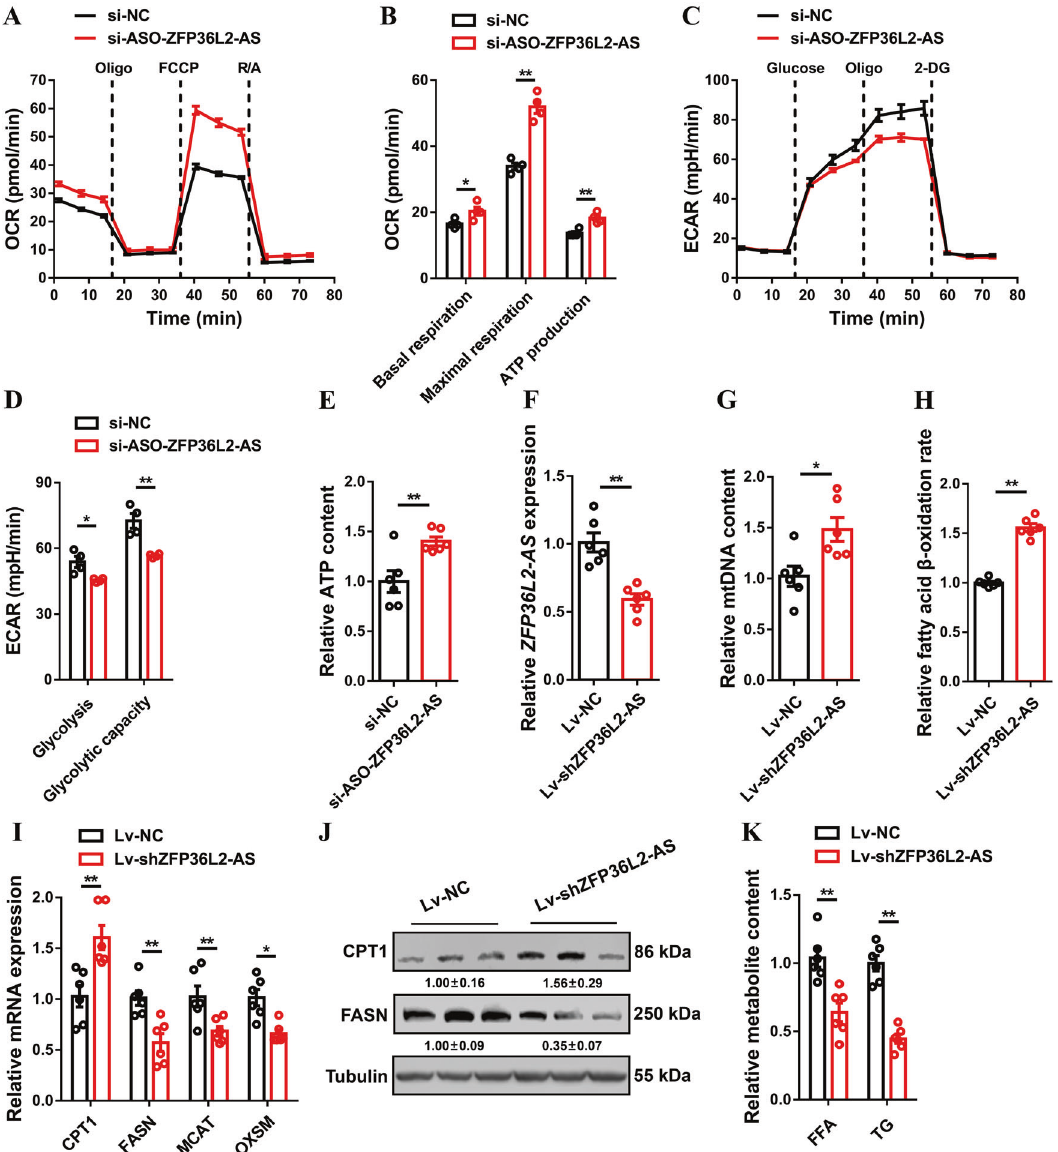
Fig. 3 lncRNA ZFP36L2-AS represses cellular respiration and fatty acid oxidation in skeletal muscle. A , B Oxygen consumption rate (OCR) ( A ), and basal respiration, maximal respiration, and ATP production ( B ) of myoblasts after interference of ZFP36L2-AS . ( C , D ) Extracellular acidi fi cation rate (ECAR) ( C ), and glycolysis and glycolytic capacity ( D ) of myoblasts with ZFP36L2-AS interference. E Relative cellular adenosine triphosphate (ATP) content with ZFP36L2-AS interference in CPMs. F Relative ZFP36L2-AS expression in gastrocnemius after infected with lentivirus-mediated ZFP36L2-AS knockdown (Lv-shZFP36L2-AS) or negative control (Lv-NC). G Relative mitochondrial DNA (mtDNA) content in ZFP36L2-AS knockdown gastrocnemius. ( H ) Relative fatty acid β -oxidation rate in gastrocnemius with ZFP36L2-AS knockdown. I , J Relative mRNA ( I ) and protein ( J ) expression levels of fatty acid oxidation or synthesis related-genes after infected with the indicated lentivirus. The numbers shown below the bands were folds of band intensities relative to control. Band intensities were quanti fi ed by ImageJ and normalized to β -Tubulin. Data are expressed as a fold-change relative to the control. K Relative free fatty acid (FFA) and triglyceride (TG) content in gastrocnemius with ZFP36L2-AS knockdown. Results are presented as mean ± SEM. In panels ( B , D – I , and K ), statistical signi fi cance of differences between means was assessed using independent sample t -test. (* P < 0.05; ** P < ZFP36L2-AS interference, whereas ZFP36L2-AS overexpression and MyHC were signi fi cantly downregulated with ZFP36L2-AS facilitated glycolysis (Fig. 3A – D and Supplementary Fig. 3A – D), interference (Fig. 2J, K). Conversely, overexpression of ZFP36L2-AS indicating that ZFP36L2-AS may be involved in cellular energy promoted their expression (Supplementary Fig. 2J, K). metabolism. Meanwhile, inhibition of ZFP36L2-AS increased ATP ZFP36L2-AS decreases cellular respiration, fatty acid content in myoblast, while ATP content was decreased with ZFP36L2-AS overexpression in myoblasts (Fig. 3E and Supplemen- oxidation, and TCA cycle metabolites in skeletal muscle tary Fig. 3E). Given that ZFP36L2-AS regulates cellular metabolism, Cellular mitochondrial activities including oxygen consumption we further detected the cellular ATP content in satellite cells after rate (OCR), basal and maximal mitochondrial respiration, and inhibition and overexpression of ZFP36L2-AS to explore whether adenosine triphosphate (ATP) production were elevated with